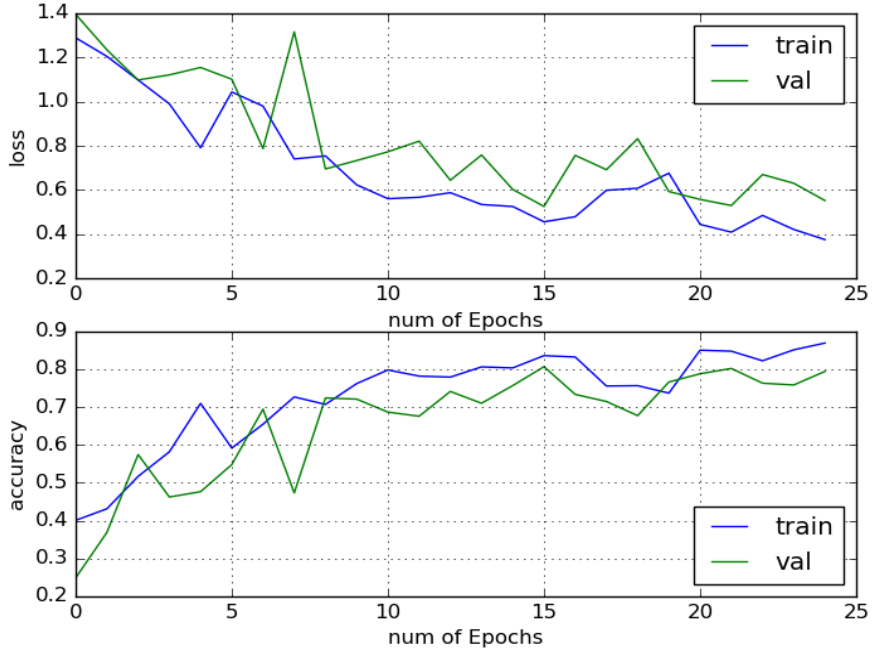
Figure 3. VGG-16 fine tune model on MLe2e using SGD